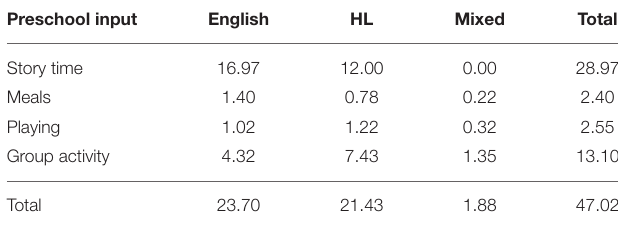
TABLE 4B | Input to preschool group in minutes.